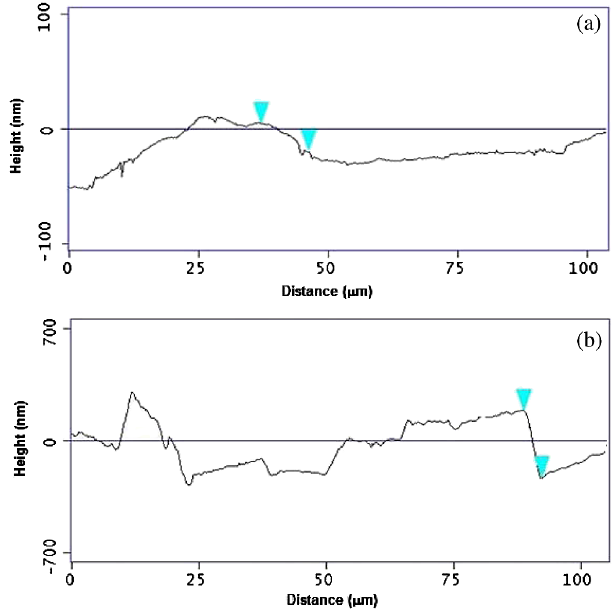
FIG. 13. Surface line profiles of nanopolished fine-grained samples: (a) as received and (b) after 6 (cid:1) m removal by